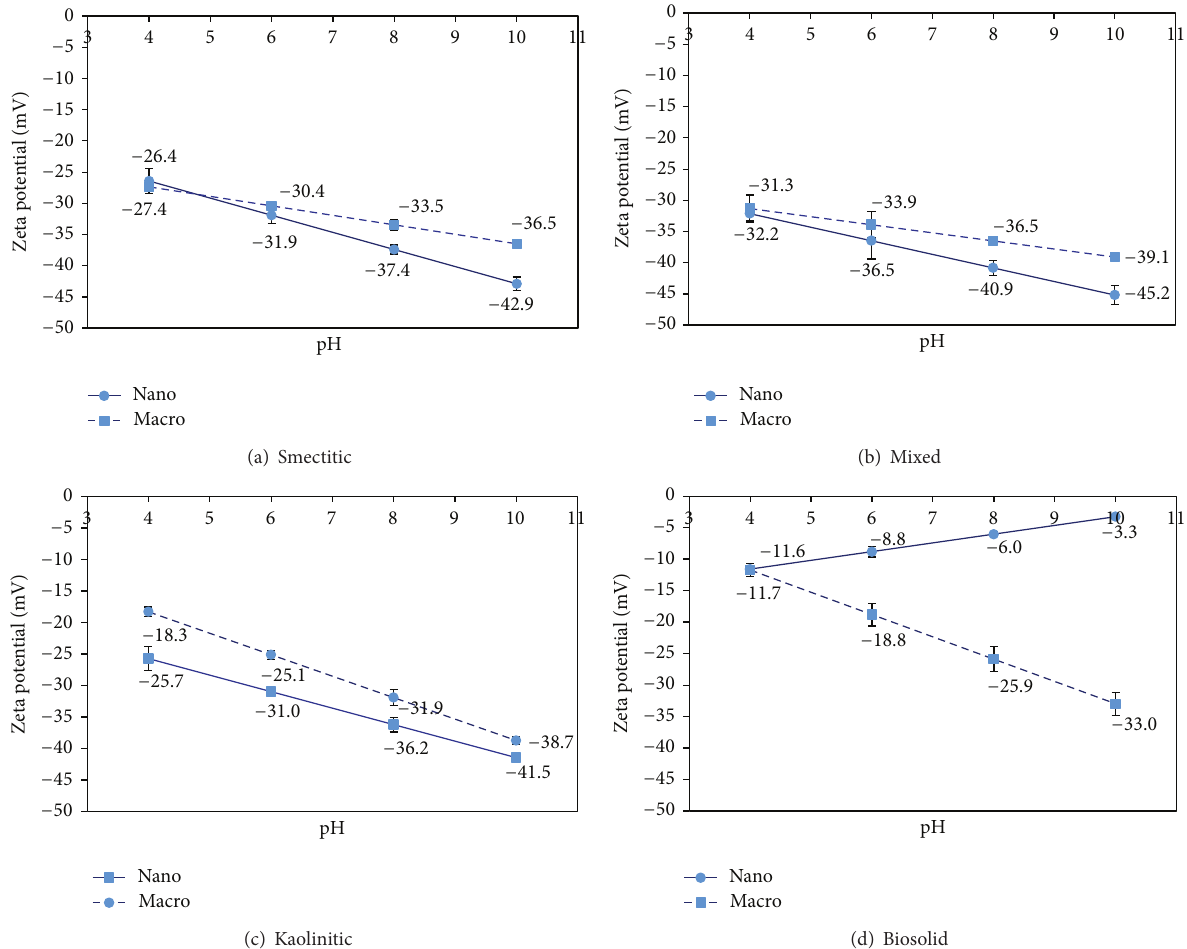
Figure4:Nano-andmacrocolloidzetapotentialasafunctionofpH.Meanvaluesoftriplicatesoilcolloidsampleswithbackgroundelectrolyte of 0.001 M NaCl. Error bars represent standard deviations among triplicate measurements.